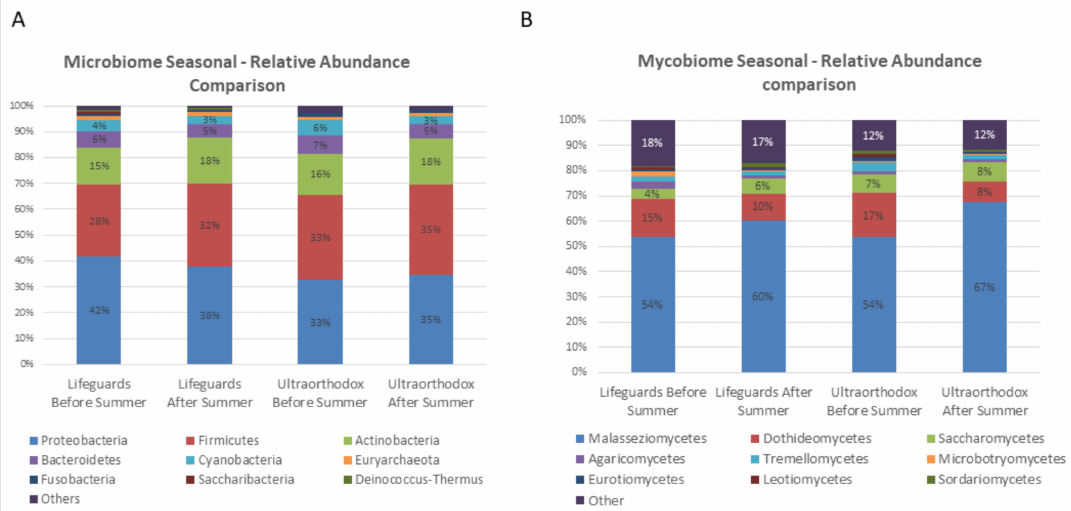
Figure 2. Seasonal comparison of mean relative abundance in microbiomes between lifeguards and ultraorthodox (>1%). ( A ) microbiome; ( B ) mycobiome. Within the mycobiome (fungal microbiome), Malasseziomycetes were the most dominant phylum both before and after summer, followed by Dothideomycetes and